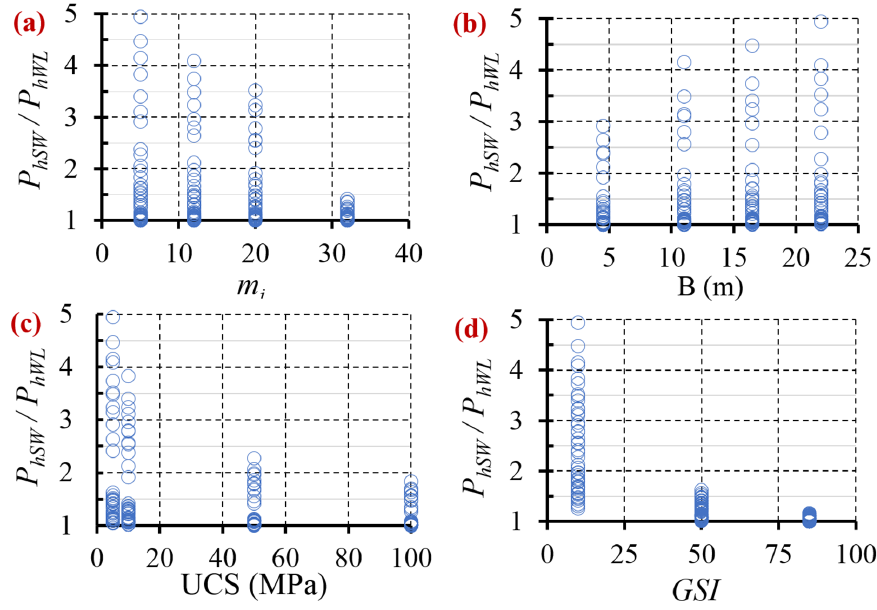
Figure 12. Correlation between P hSW and P hWL , depending on: ( a ) m i ; ( b ) B ; ( c ) UCS ; ( d ) GSI .